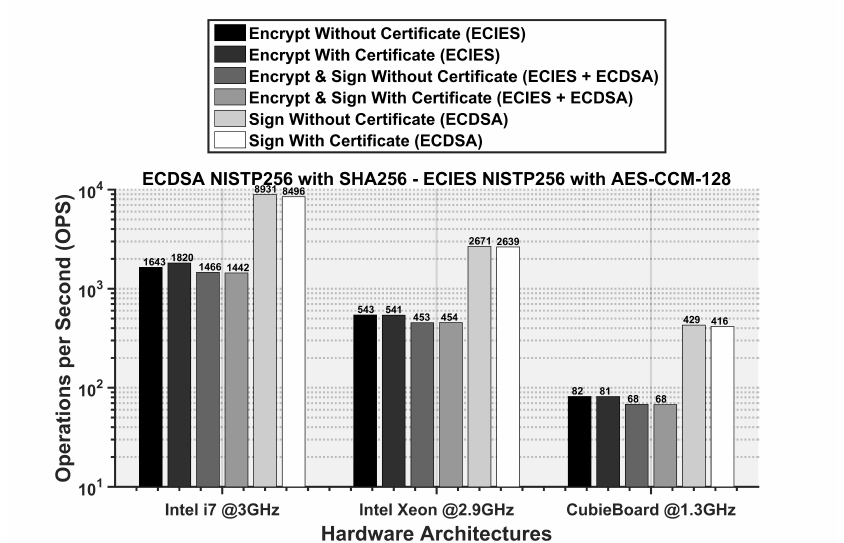
Figure 12. Required operations per second (OPS) for different ENCAP procedures in conformance with the ETSI